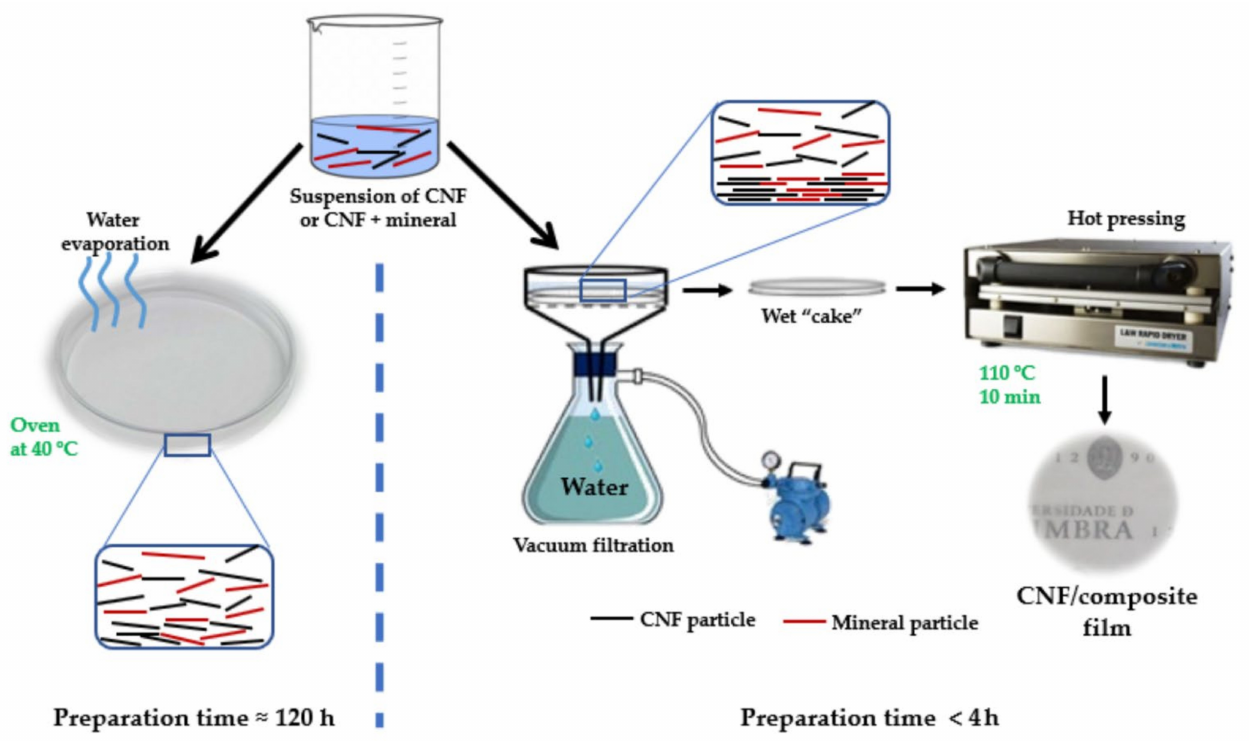
Figure 12. Schematic of fabrication of CNF/clay composite films via solvent casting and vacuum filtration/hot-pressing method [123]. (Open